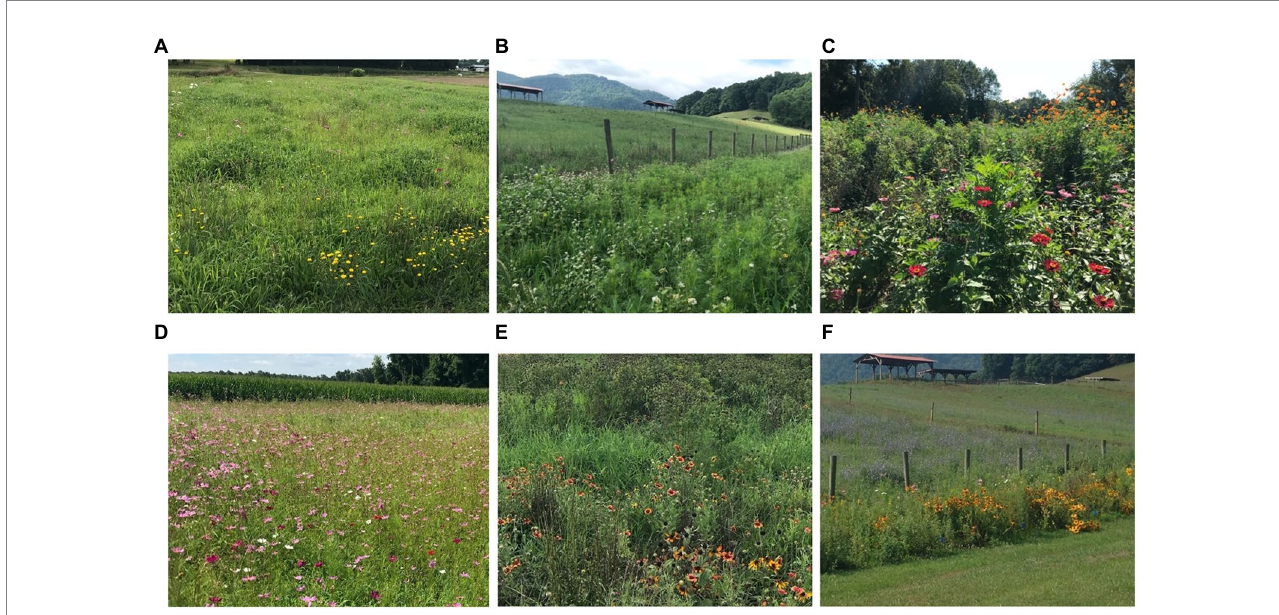
FIGURE 1 Examples of various levels of plot cover (A–C) and plot diversity (D–F) . Picture A (Central Crops 2018) represents a low flower cover, Picture B (Mountain 2018) represents medium flower cover, and Picture C (Peanut Belt 2018) represents high flower cover. Picture D (Border Belt 2018) represents low flower diversity, Picture E (Caswell 2018) represents medium flower diversity, and Picture F (Mountain 2016) represents high flower